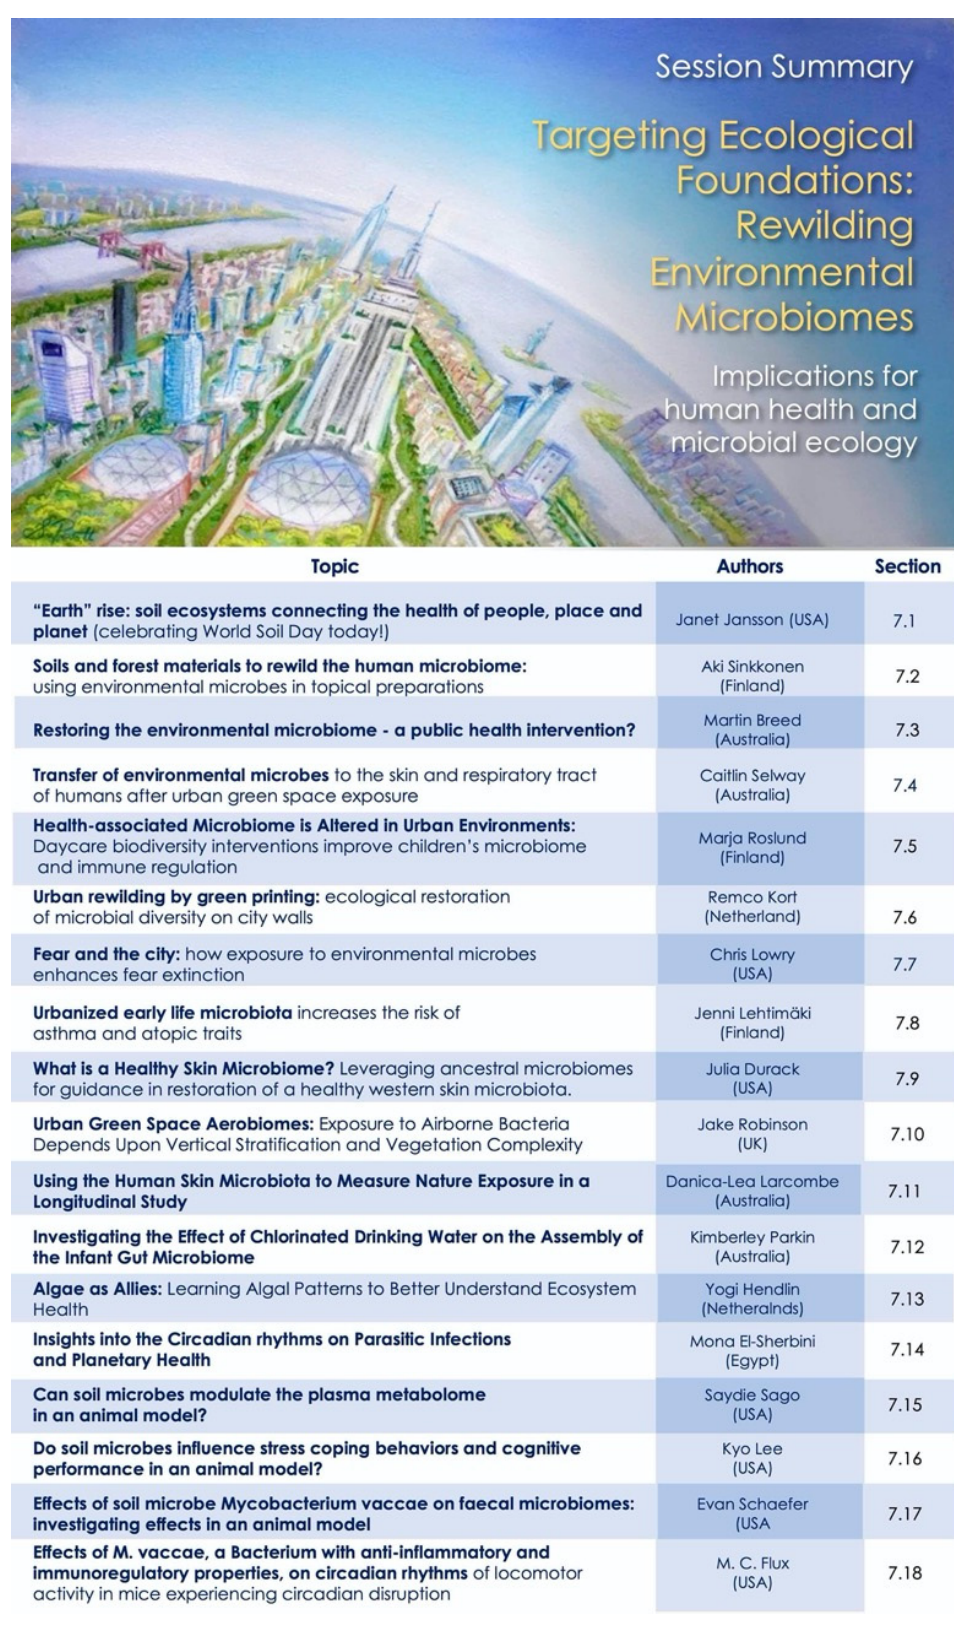
Figure 6. Targeting Ecological Foundations: Rewilding Environmental Microbiomes. Overview of topics and speakers in the session on microbial ecology for health at all scales.